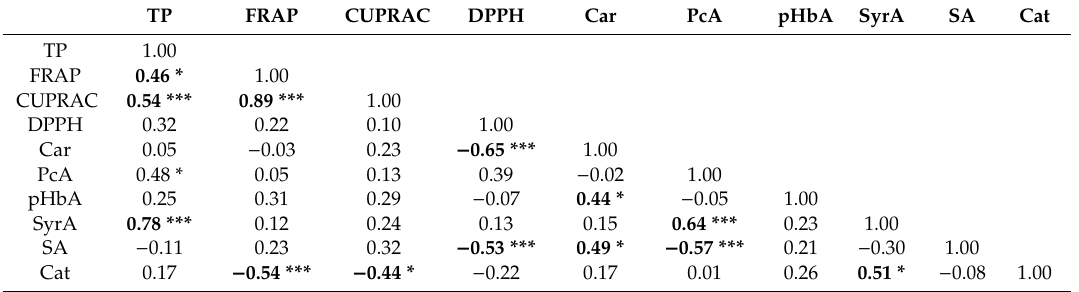
Table 3. Correlation matrix for selected antioxidant parameters of fruit pulp of Cucurbita cultivars. TP FRAP CUPRAC DPPH Car PcA pHbA SyrA SA